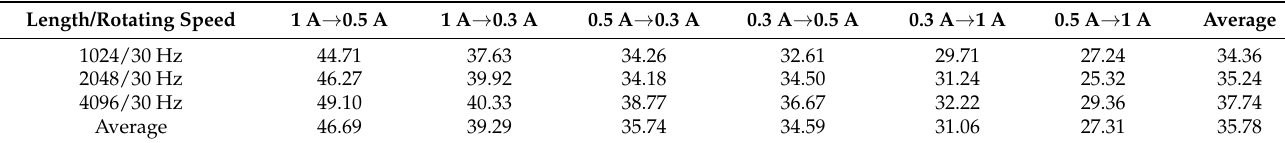
Table 6. Load adaptability test results.